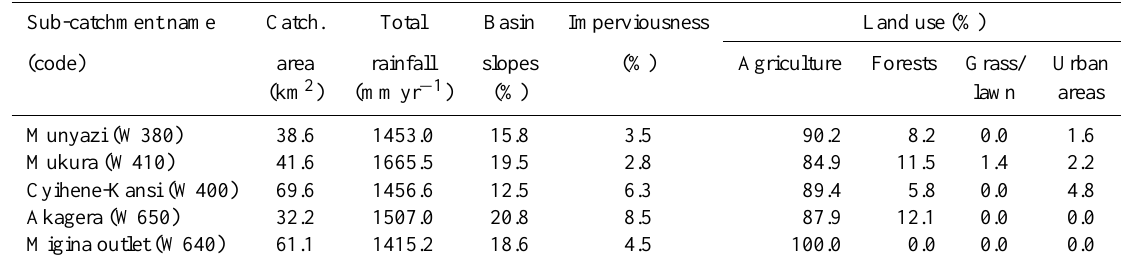
Table 1. Migina Catchment and sub-catchments characteristics. Sub-catchment name Catch. Total Basin Imperviousness Land use (%) (code) area rainfall slopes (%) Agriculture Forests Grass/ Urban (km 2 ) (mmyr − 1 ) (%) lawn areas Munyazi (W380) 38.6